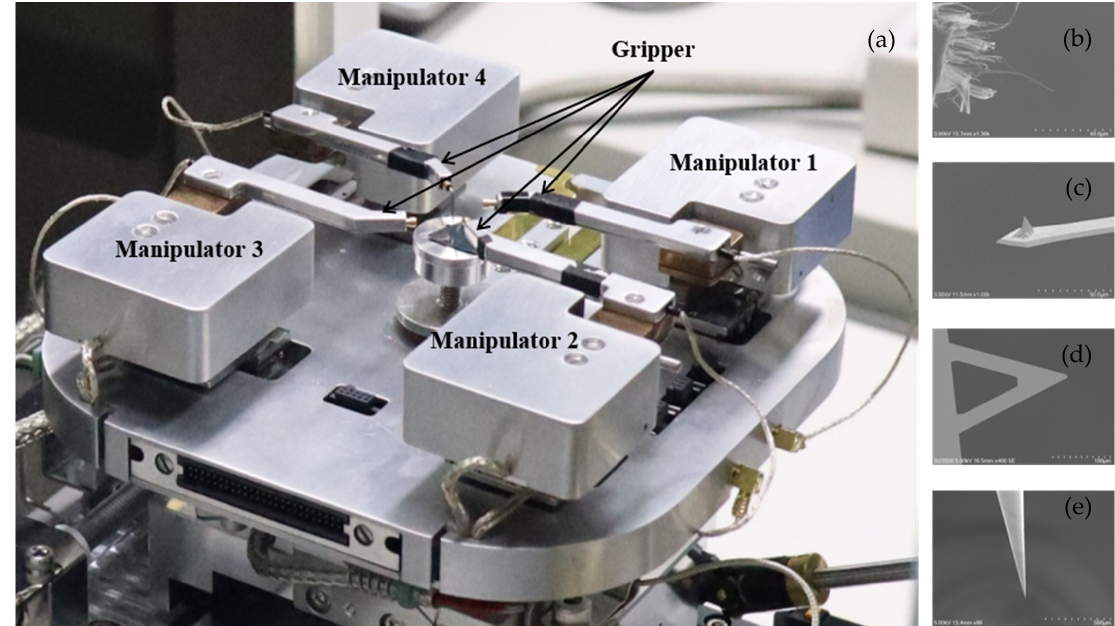
Figure 1. ( a ) AFMSEM-based nanoscale robotic manipulator system, ( b ) MWCNT bundle sample; ( c ) gold-coated AFM cantilever with tip; ( d ) tip-less gold-coated AFM cantilever; ( e ) tungsten probe.